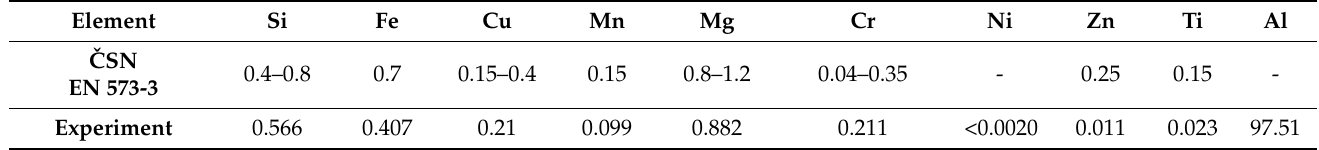
Table 1. Chemical composition of alloy AW 6061 (wt%).